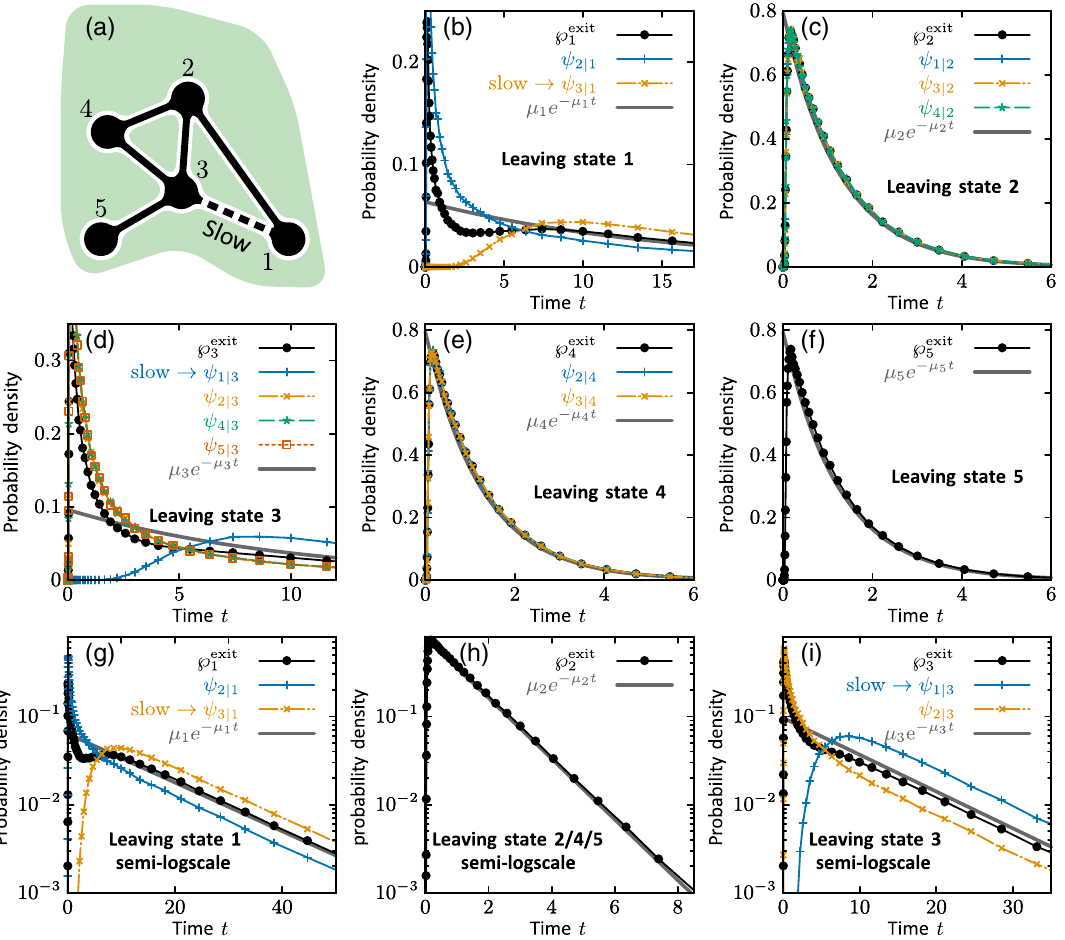
FIG. 14. State-to-state kinetics in the synthetic network. (a) Schematics of the network with a slow transition between states 1 and 3 T barriers separating the network states. (dashed line). All remaining connections (solid lines) are chosen to be equally fast with 3 k B (b) – (f) Probability density of local residence time ℘ loc starting from (b) i ¼ 1 , (c) i ¼ 2 , (d) i ¼ 3 , (e) i ¼ 4 , and (f) i ¼ 5 , which are j j i deduced from 400 000 repeated exit events, respectively. The gray solid line denotes the estimated long-time asymptotics with the values from Table IV. The densities of leaving states 2, 4, and 5 are identical for the synthetic model. (g) – (i) Probability densities on a log scale; redundant densities are omitted since ℘ exit 2 ¼ ℘ exit 4 ¼ ℘ exit 5 holds, and all histograms plotted in (c) and (e) correspond to the same density, respectively, as well as ℘ loc 2 ¼ ℘ loc 4 ¼ ℘ loc 5 j 3 j 3 j 3